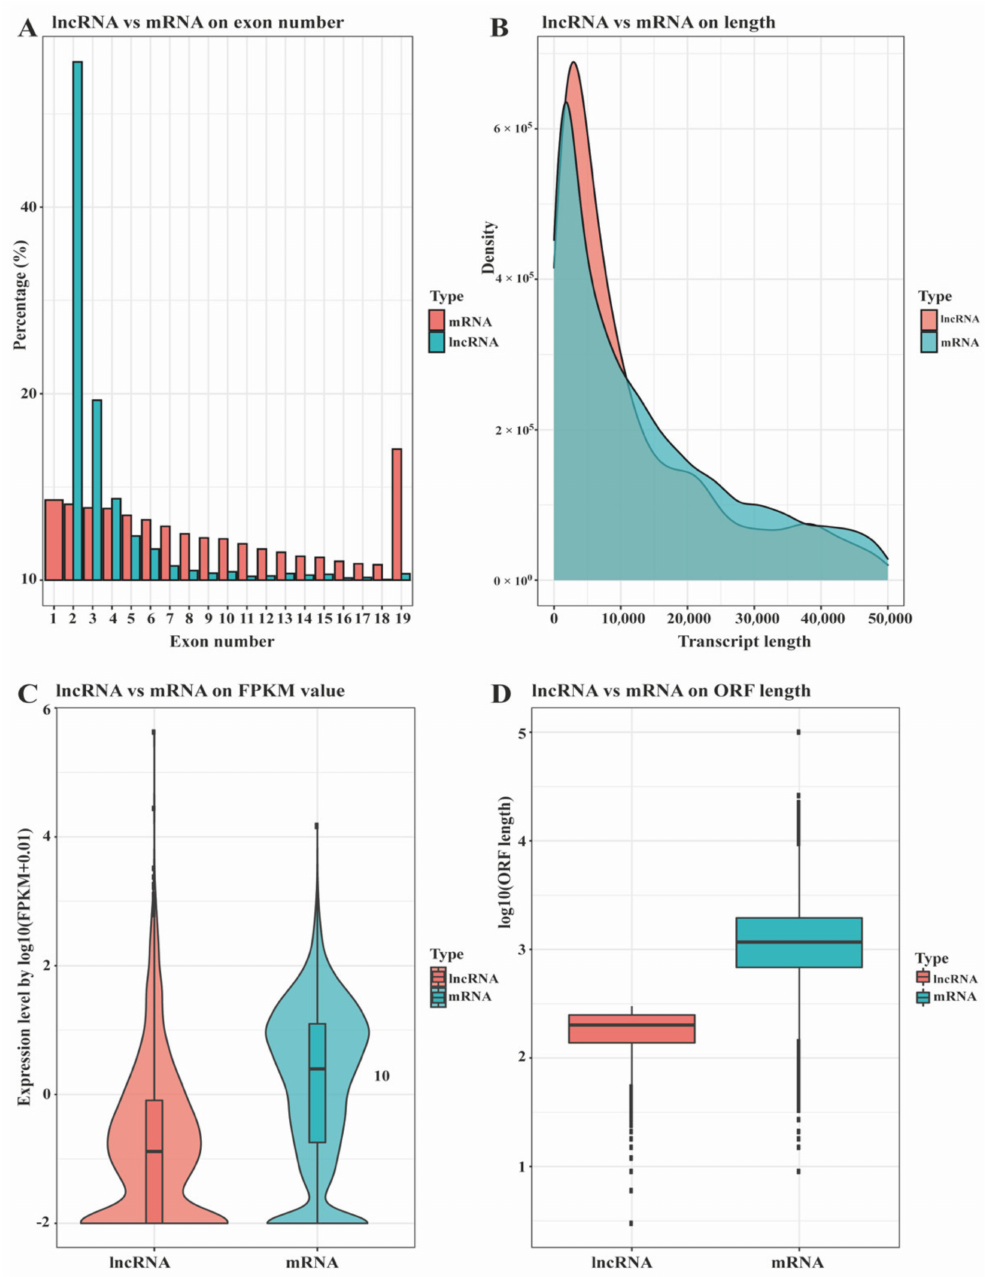
Figure 1. Genomic classification of lncRNA and mRNA transcripts was compared by ( A ) exon number, ( B ) length, ( C ) fragments per kilobase of exon per million mapped reads (FPKM) value, and ( D ) open reading frame (ORF)